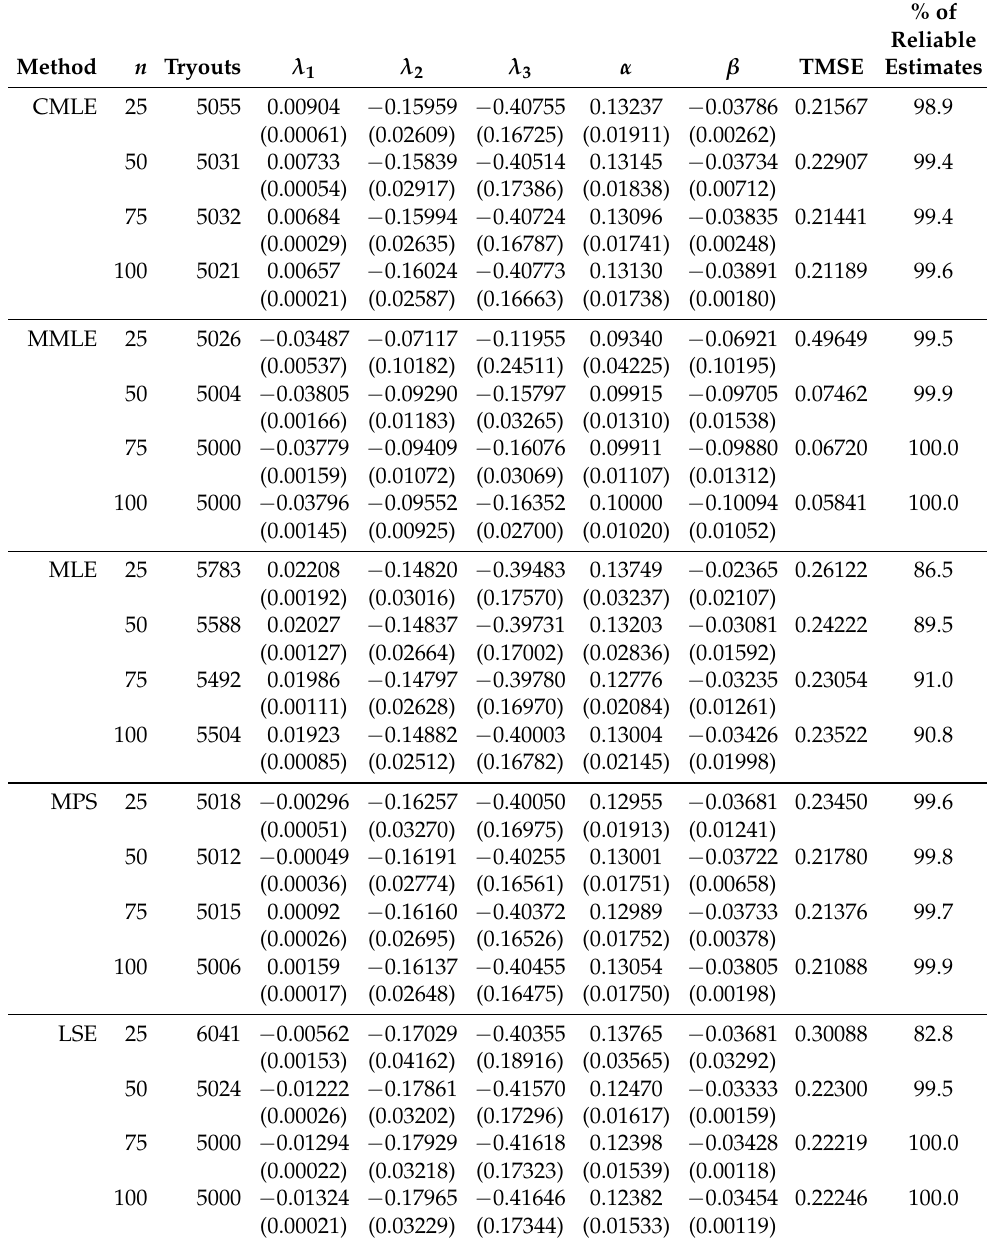
Table 8. Simulated biases and MSEs (in parentheses) of the parameter estimates obtained based